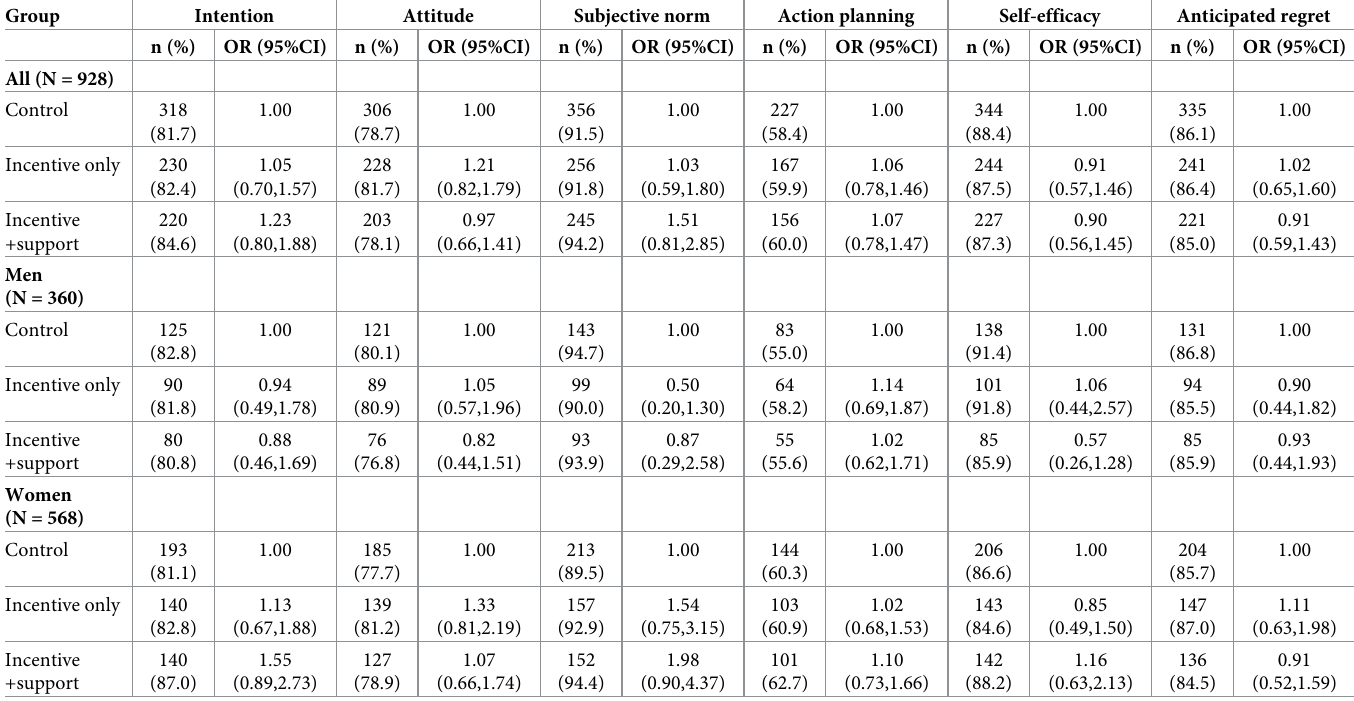
Table 5. Social and cognitive determinants of PA at 12 months. Group Intention Attitude Subjective norm Action planning Self-efficacy Anticipated